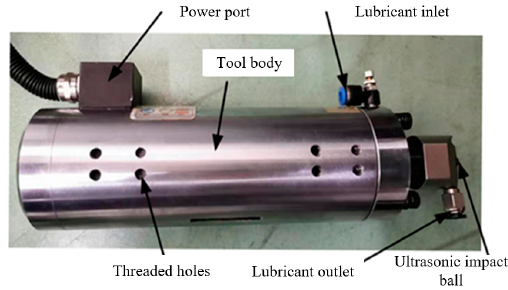
Figure 3. Ultrasonic impact